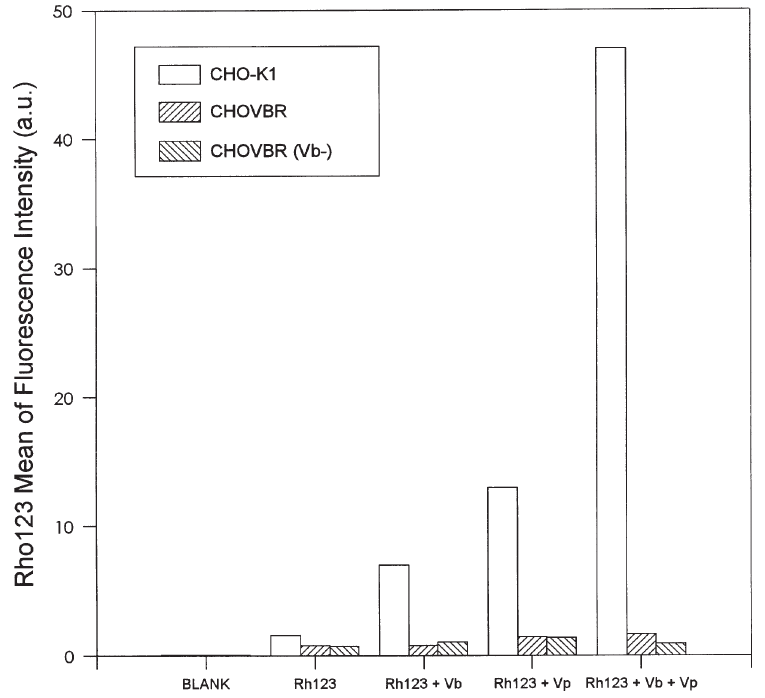
Fig. 5. Experiments of rhodamine 123 retention with CHO-K1 and CHOVBR cells. Cells were incubated in the absence or in the presence of verapamil and vinblastine. Drug sensitive cells (CHO-K1) had P-gp inhibition, but CHOVBR drug resistant cells, even one month vinblastine deprived CHOVBR (VB-) cells, did not had efflux inhibition. Data shown are representative of three separate